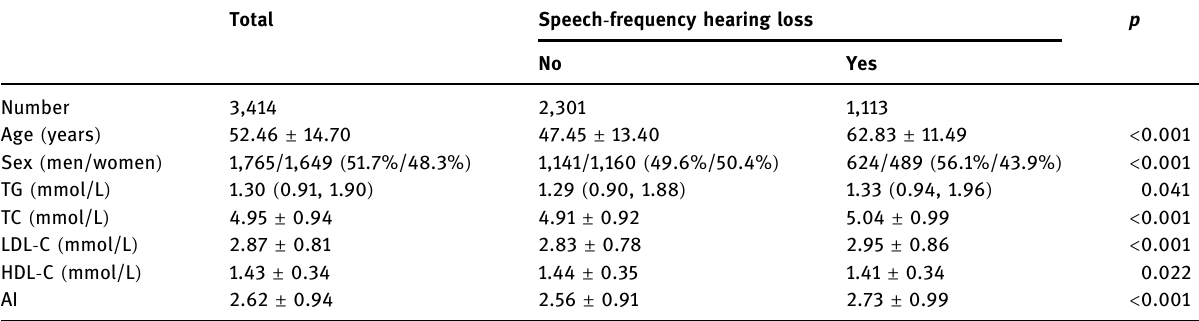
Table 1: Comparison of demographic and clinical characteristics between hearing loss and the normal group